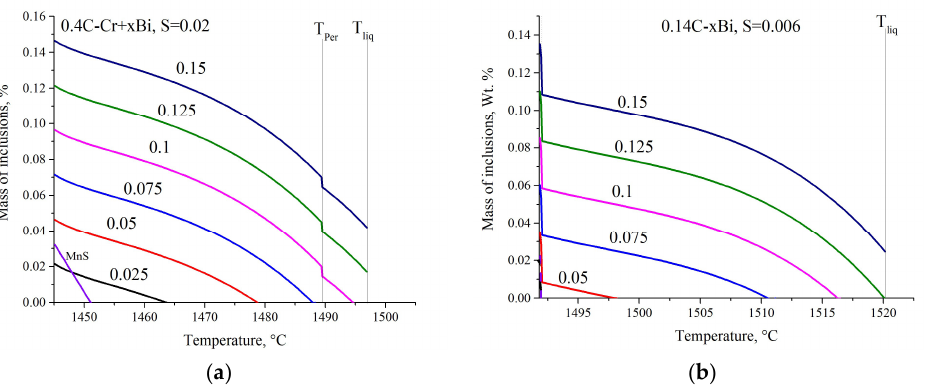
Figure 4. Influence of the initial concentration of bismuth and sulfur on the formation of bismuth and sulfide particles in steel 0.4C-Cr ( a ) and 0.14C ( b ). The numbers near the curves are the corresponding concentrations of bismuth.